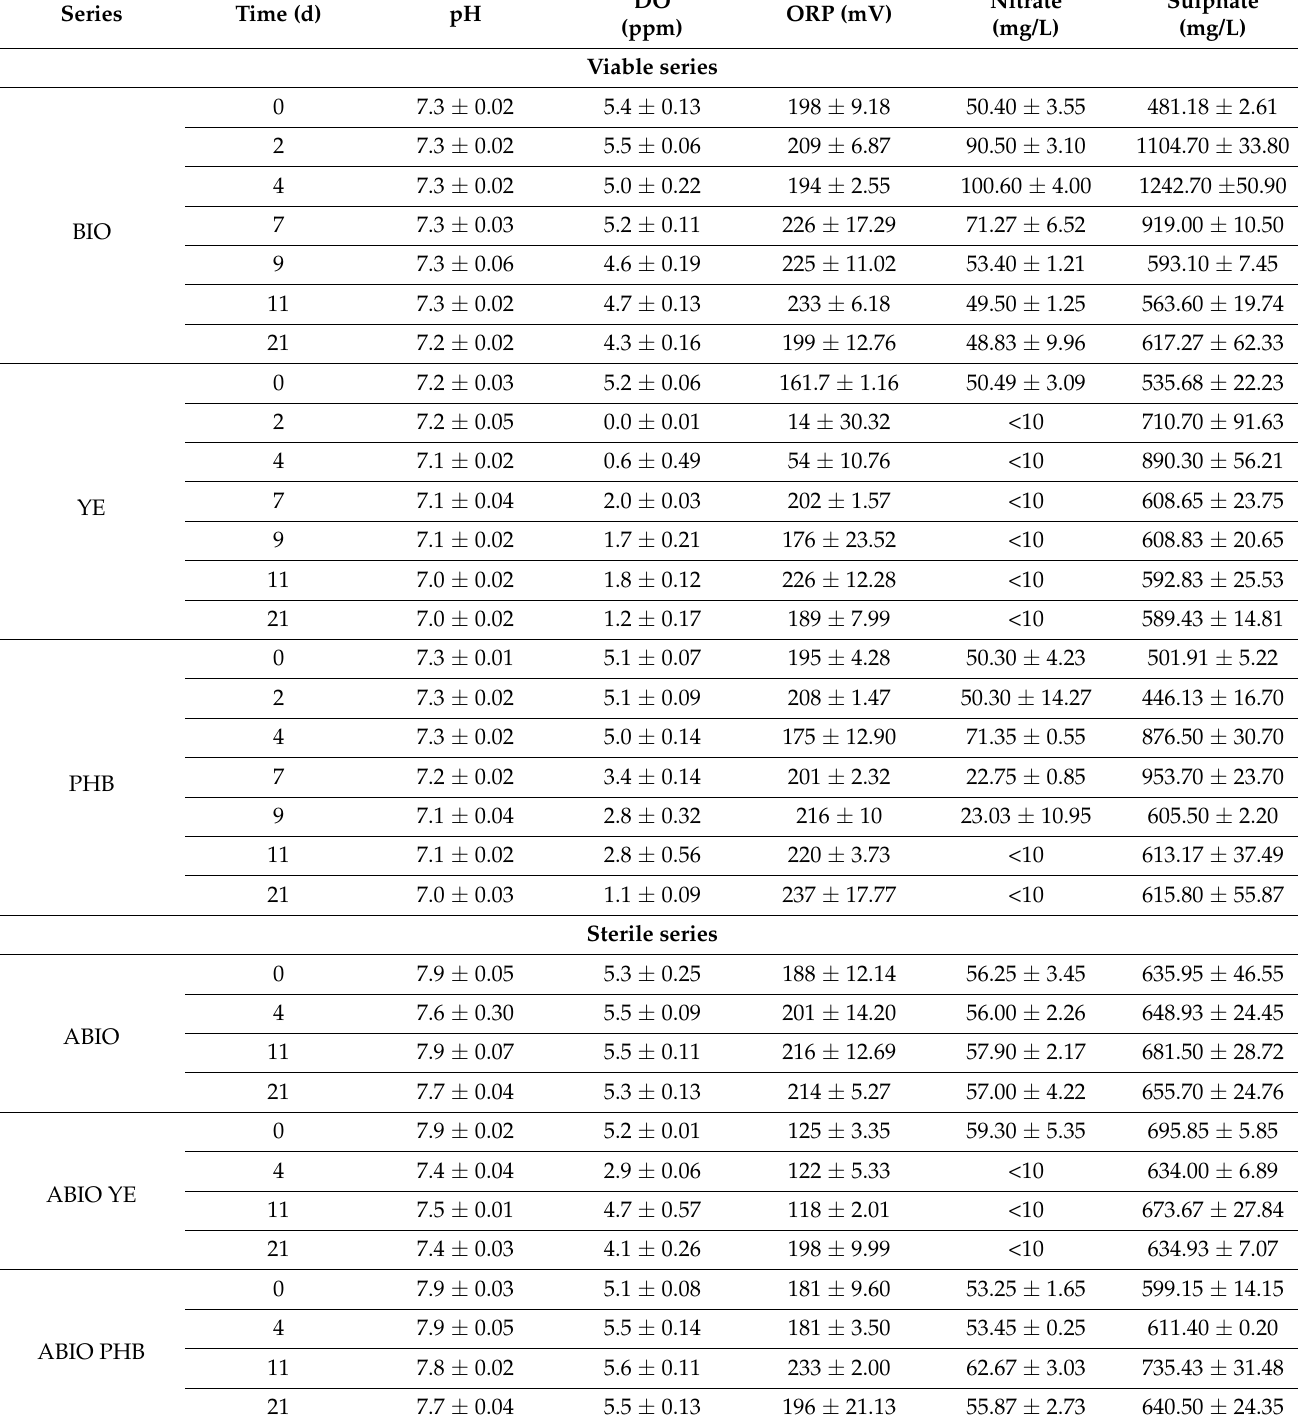
Table 3. Mean values of the pH, DO, ORP, nitrate, and sulphate measured in the viable and sterile reactors at fixed monitoring